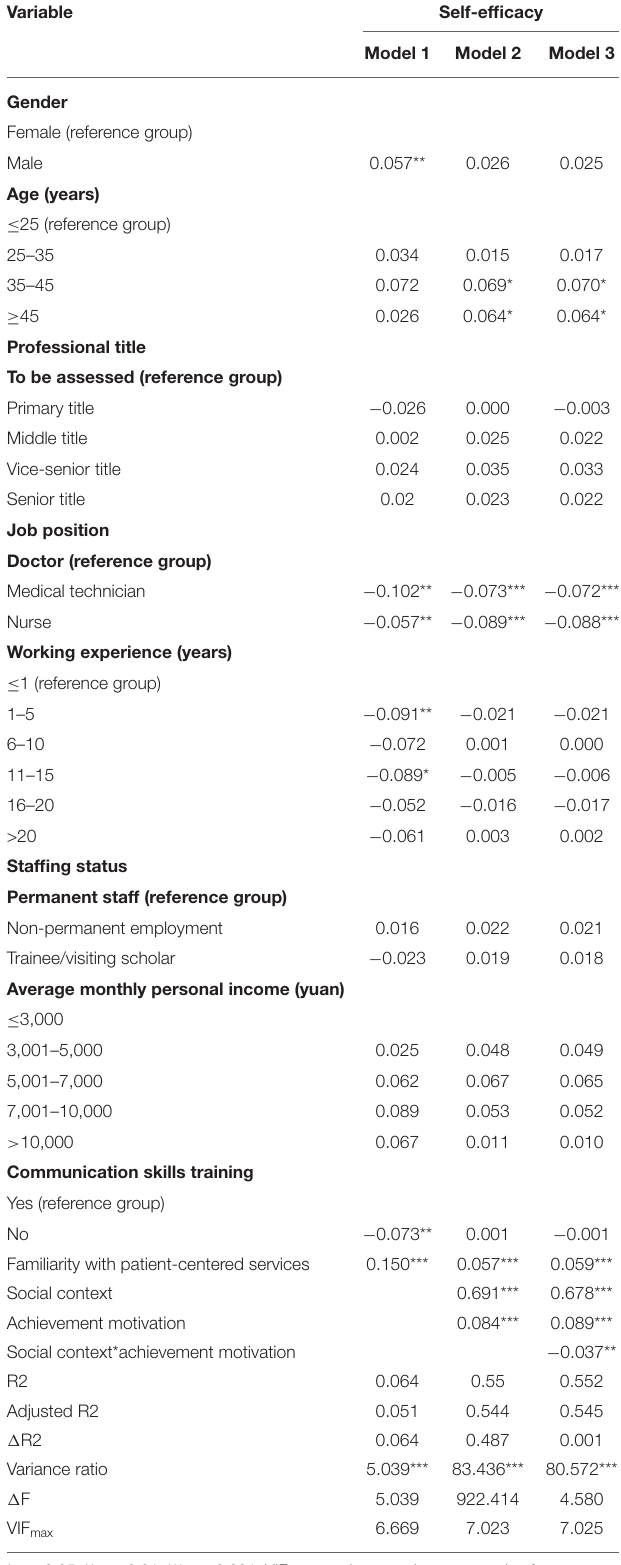
TABLE 6 | Moderating effect of achievement motivation of medical